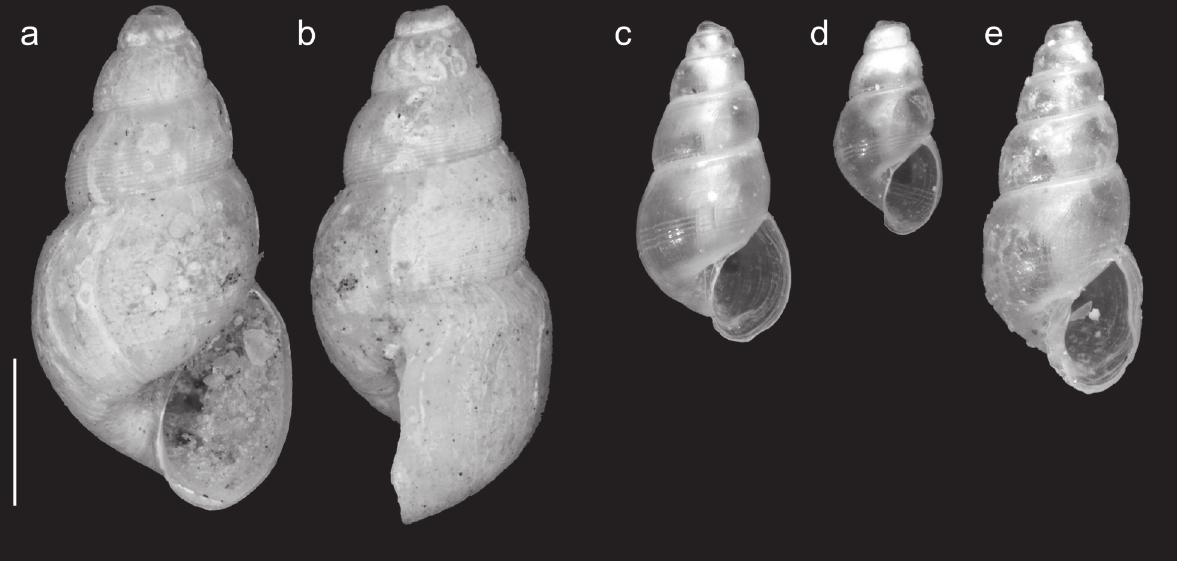
Figure 3. A. Shell of Ondina hendersoni , holotype (USNM 203813) in apertural view; B. same, in lateral view. C. Shell of Ondi- na stocki , holotype (ZMA.MOLL. 138319) in apertural view [photo: Naturalis, Jeroen Goud. D. Ondina stocki , paratype (ZMA. MOLL. 138320), smaller shell in apertural view; E. same, bigger shell in apertural view. Scale bar: 1